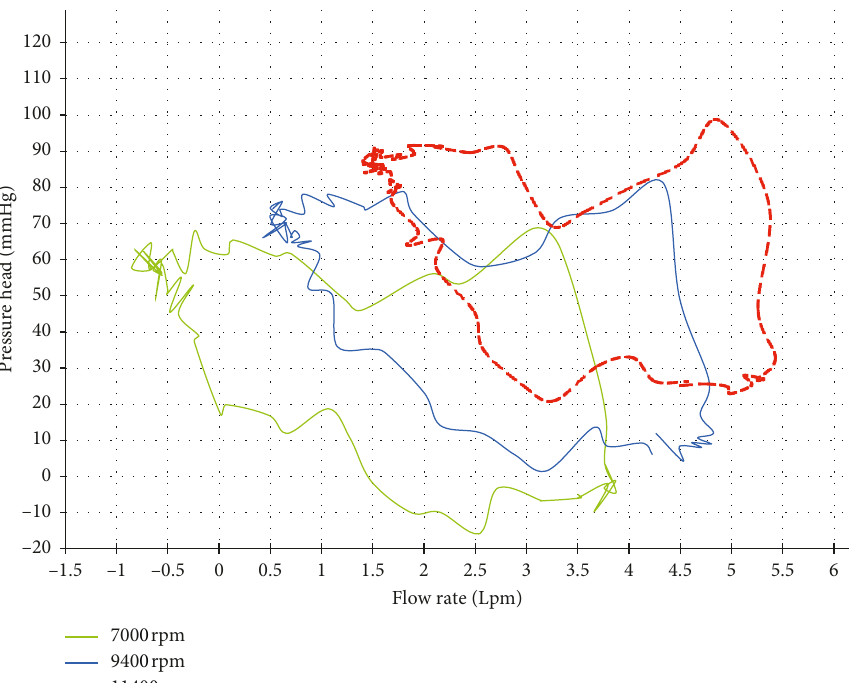
Figure 12: Dynamic pressure head-flow rate curves of Sputnik PRBP supporting failing pediatric LV at the pump speeds for the partial support state (green), the partial-to-full support change (blue), and the full support state (red) with the total work attaining normal LV stroke work